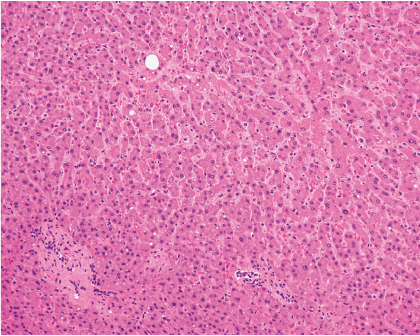
Figure 3: Native liver explant, H&E, 20x. Sections show an un- remarkable liver with no significant fat, fibrosis, or